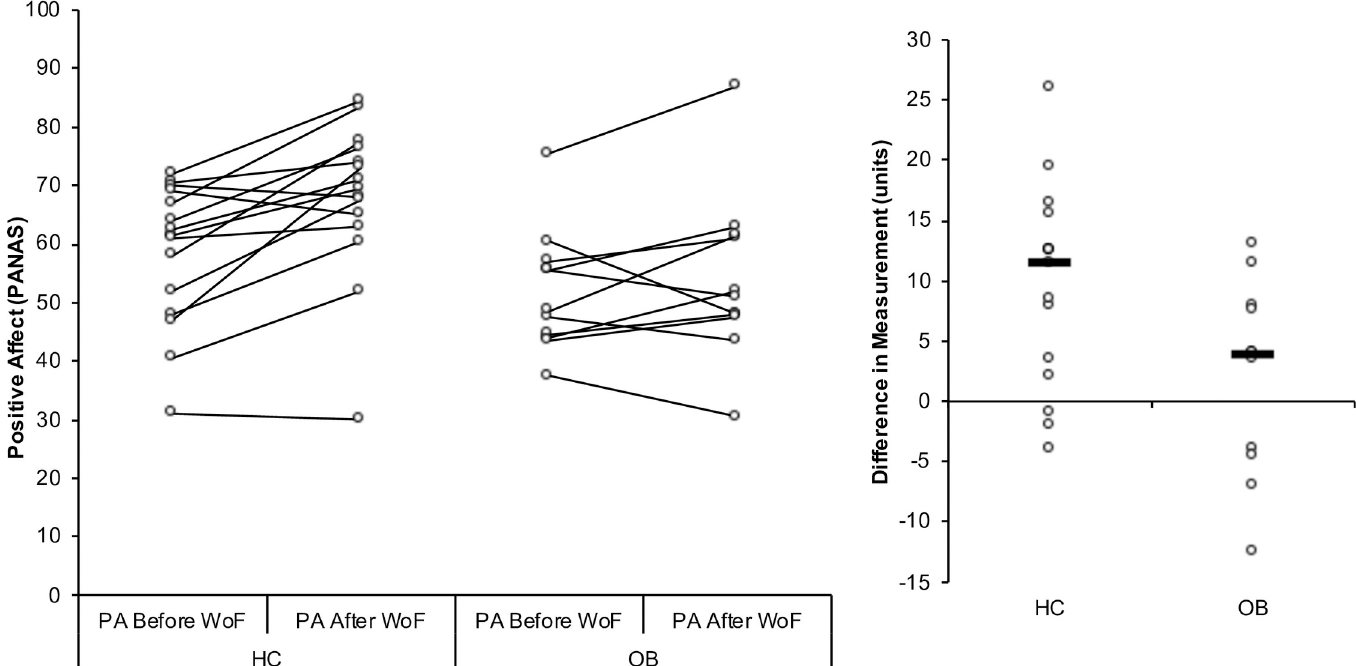
Fig 2. Affect ratings. Affect rating as measured by the PANAS across groups. Overall, OB showed more negative affect than HC ( � p < 0.05) regardless the state. Only HC showed increased positive affect after the reward task (T2) in comparison to T1 ( �� p < 0.05). There was no significant difference for OB.